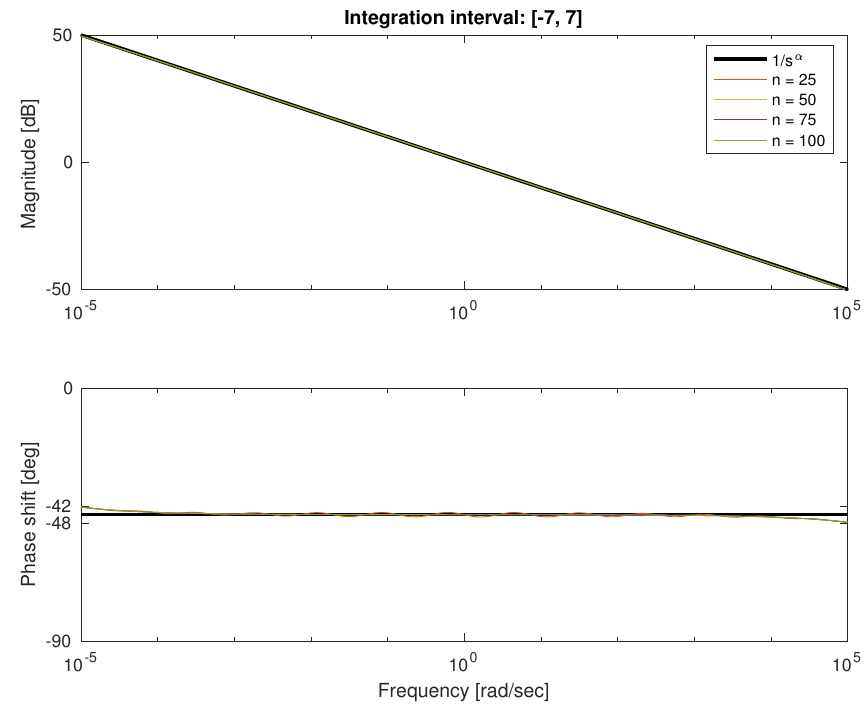
Figure 13. Analysis of frequency responses approximations with Gauss–Legendre quadrature and the integration interval of [ − 7,7 ]